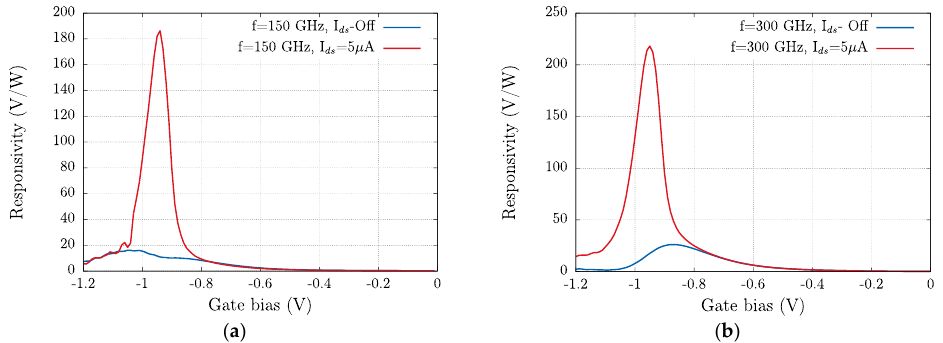
Figure 9. ( a ) Responsivity of the strained-Si MODFET from measurements under an excitation of 150 GHz in the photovoltaic mode ( I ds off) and for a bias source-to-drain current I ds = 5 µA; ( b ) same as ( a ) under an excitation of 300 GHz.